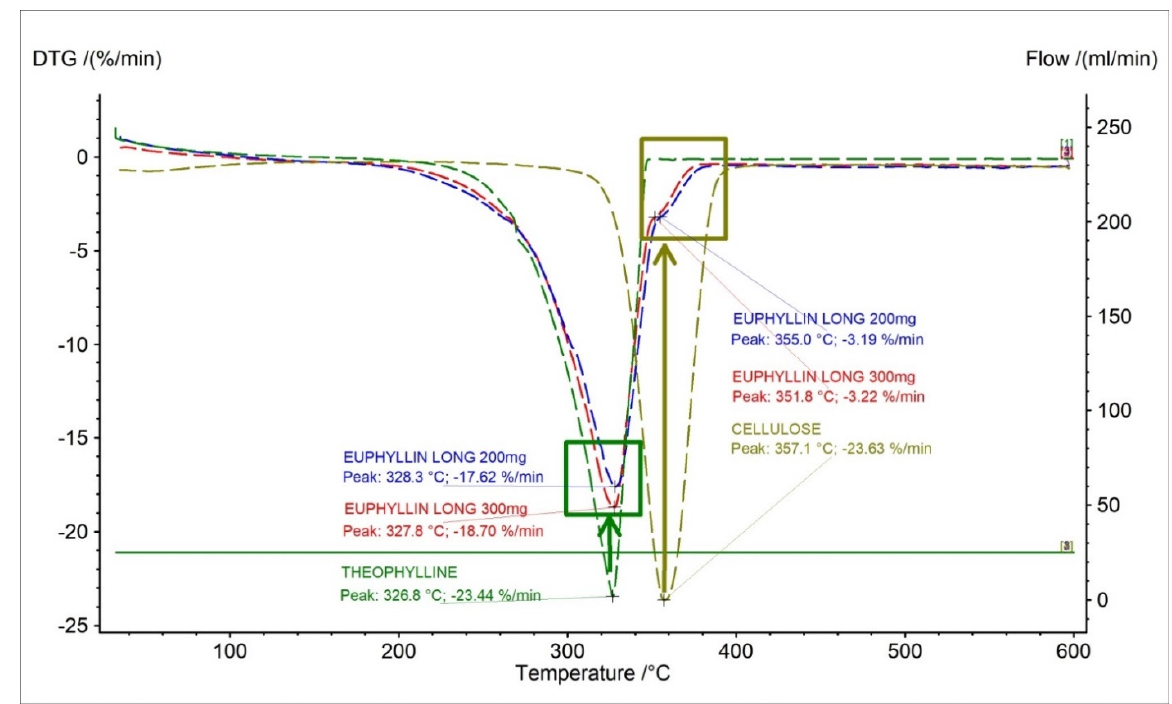
Figure 5. DTG curves for theophylline standard, Euphyllin ® long (200 mg, 300 mg) and microcrys- talline cellulose.